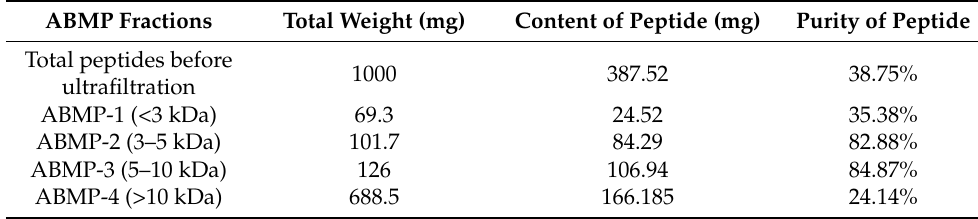
Table 3. Total weight and peptide purity of different ABMP